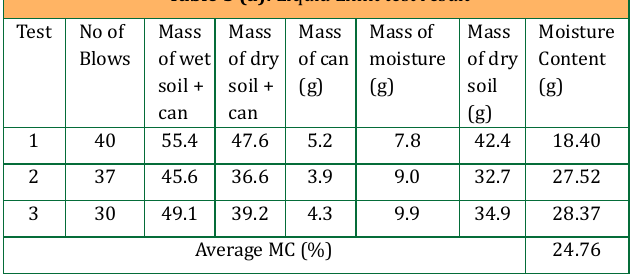
Table 5 (a): Liquid Limit test result